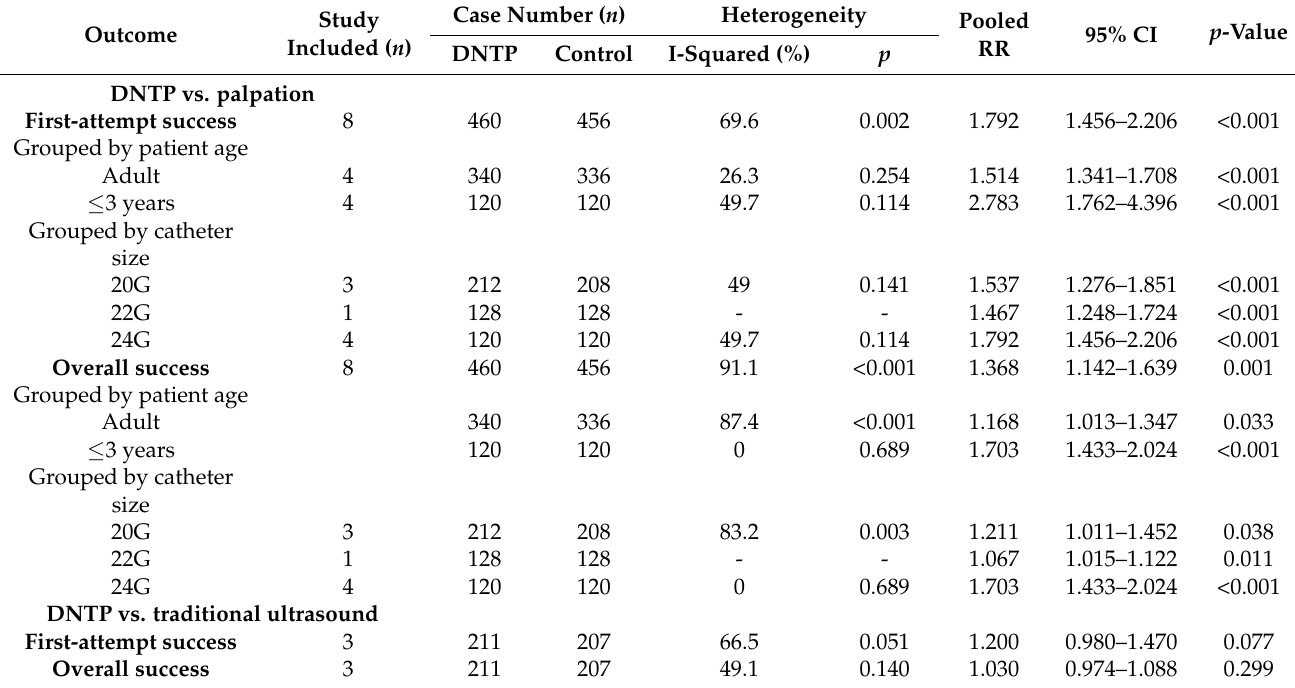
Table 2. Meta-analysis and subgroup analysis in success rate of DNTP vs. conventional palpation or ultrasound approach.